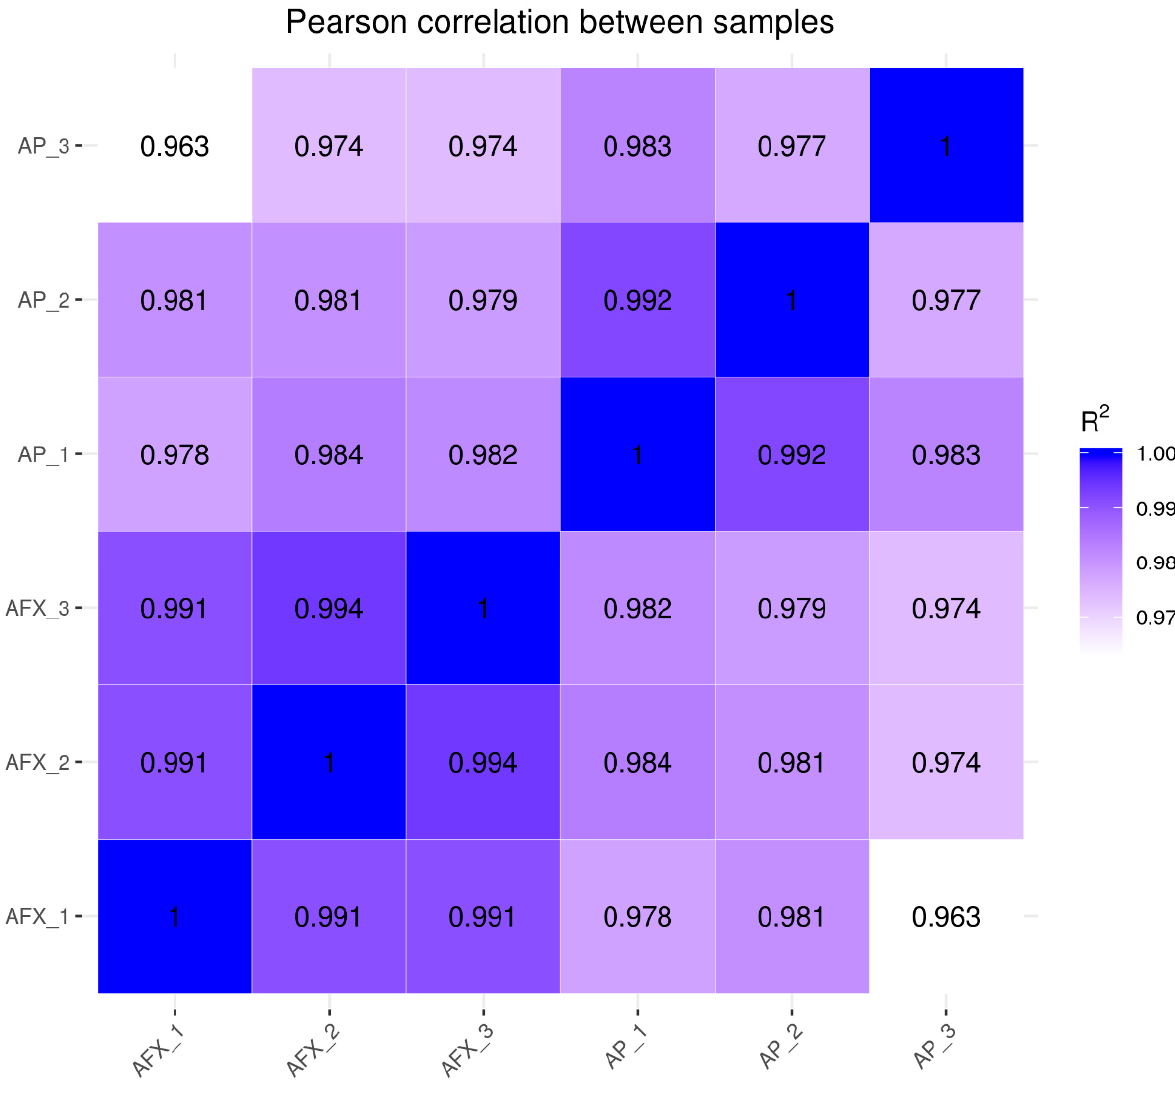
Figure 2. Pearson correlation between the AP and AXP groups. AP, the P. pastoris cell expressing the antibacterial peptide (autolysis group) . AXF, the P. pastoris cell expressing the aflatoxin-detoxifizyme (ADTZ) (non-autolysis group).